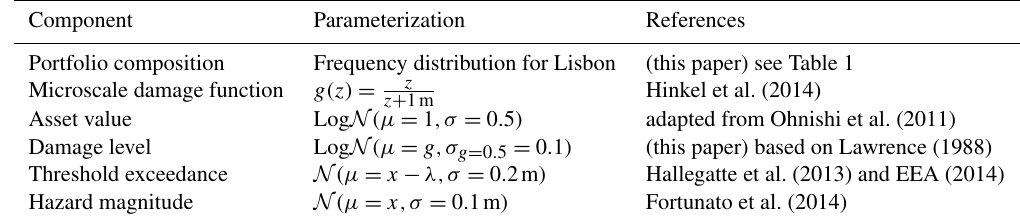
Table 2. Parameterization of the probabilistic damage function for the estimation of damage from coastal flooding in Lisbon. The variables µ and σ denote the mean and standard deviation respectively.